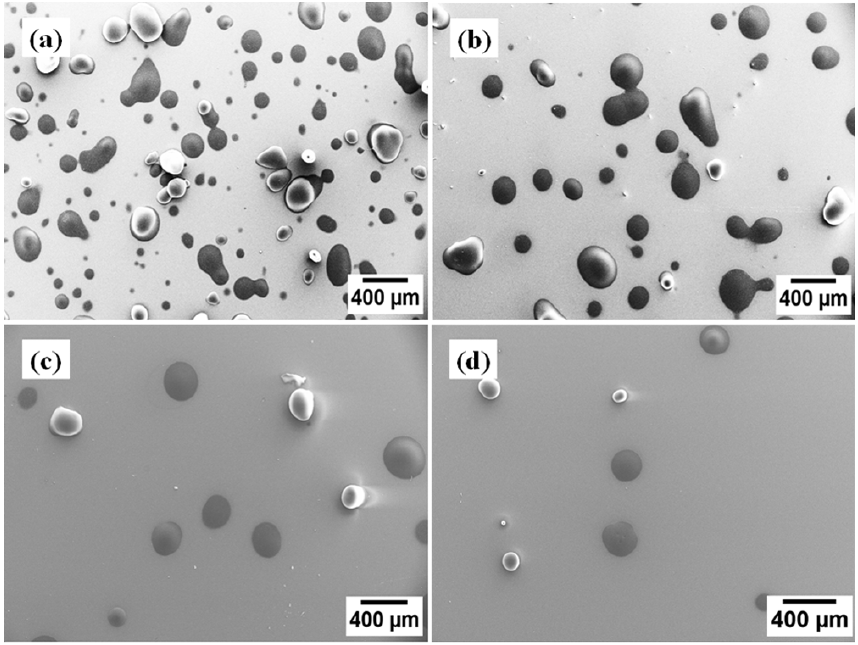
Figure 10. The single splat deposit on heated glass substrates at ( a ) 15 cm stand-off distance; ( b ) 20 cm stand-off distance; ( c ) 25 cm stand-off distance and ( d ) 30 cm stand-off distance.